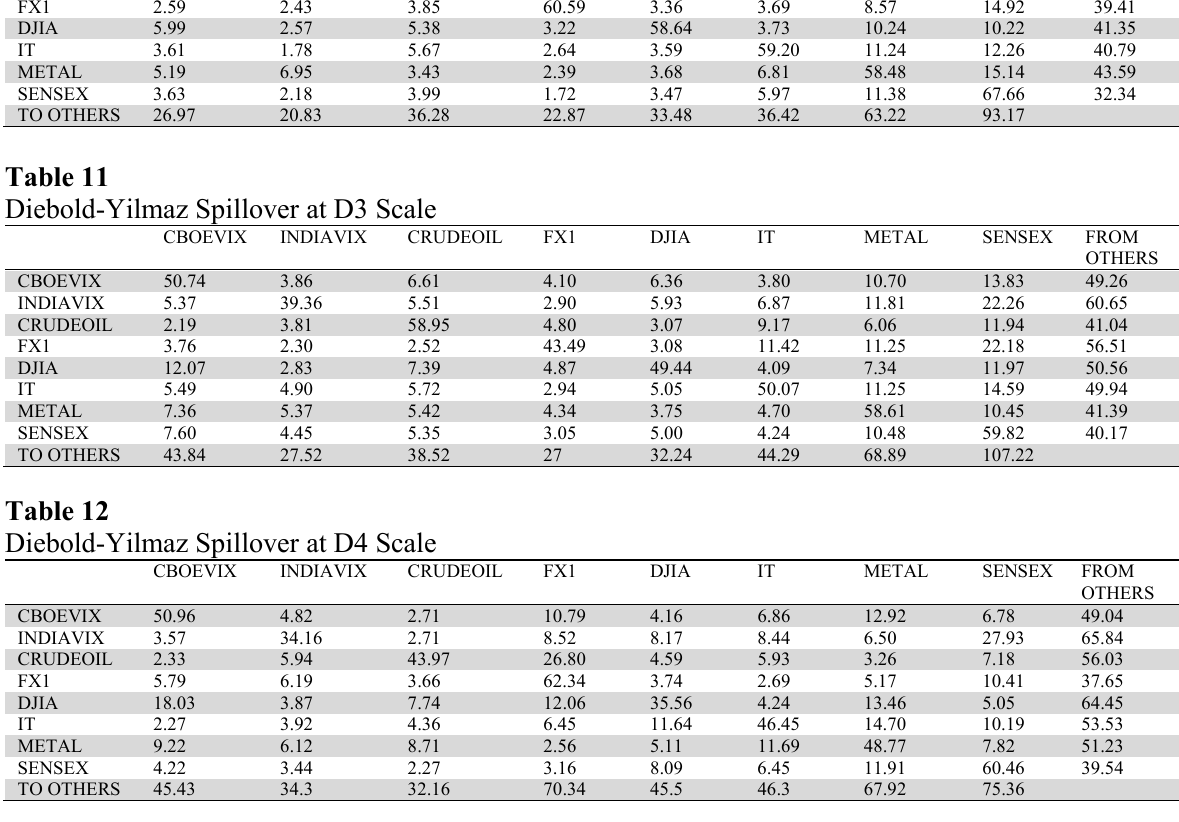
Diebold-Yilmaz Spillover at D2 Scale CBOEVIX SENSEX FROM CBOEVIX